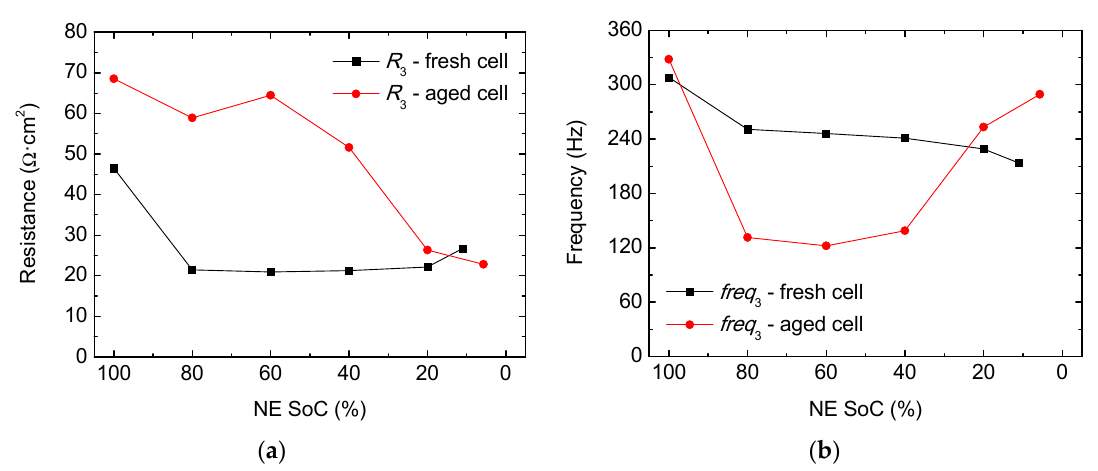
Figure A1. ( a ) Resistance and ( b ) characteristic frequency related to P3_NE measured at the graphite/Li half-cell at 25 °C. Batteries 2018 , 4 , x FOR PEER REVIEW